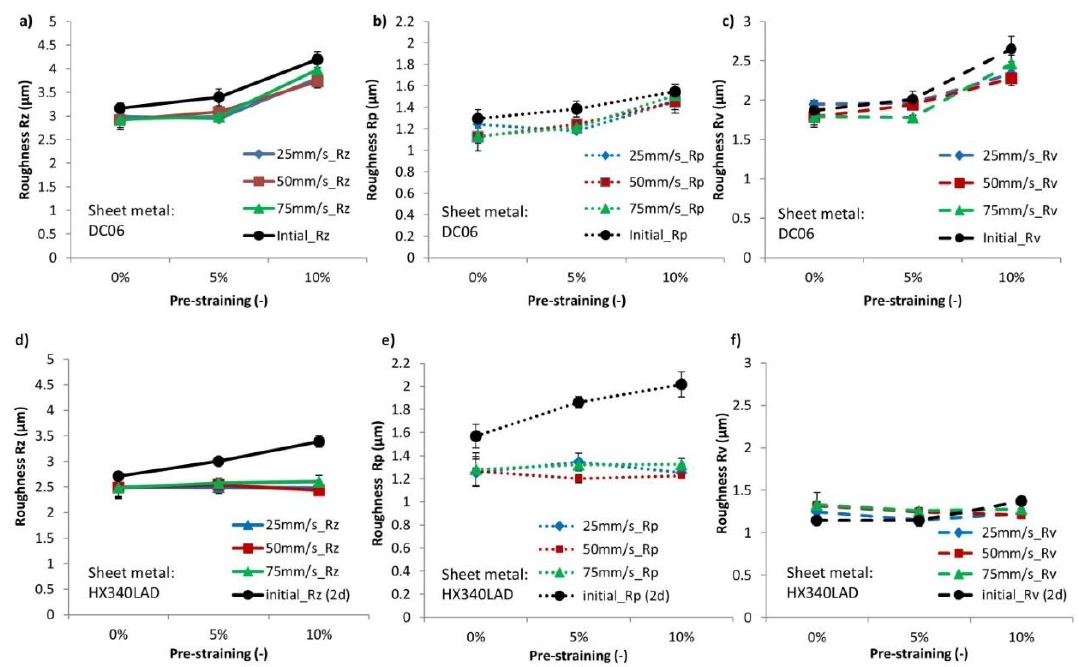
Figure 13. Surface roughness of different pre-straining with variable sliding speed under a pressure of 2.5 MPa ( a ) Rz, ( b ) Rp, ( c ) Rv of the surface DC06; surface roughness ( d ) Rz, ( e ) Rp, ( f ) Rv of the surface